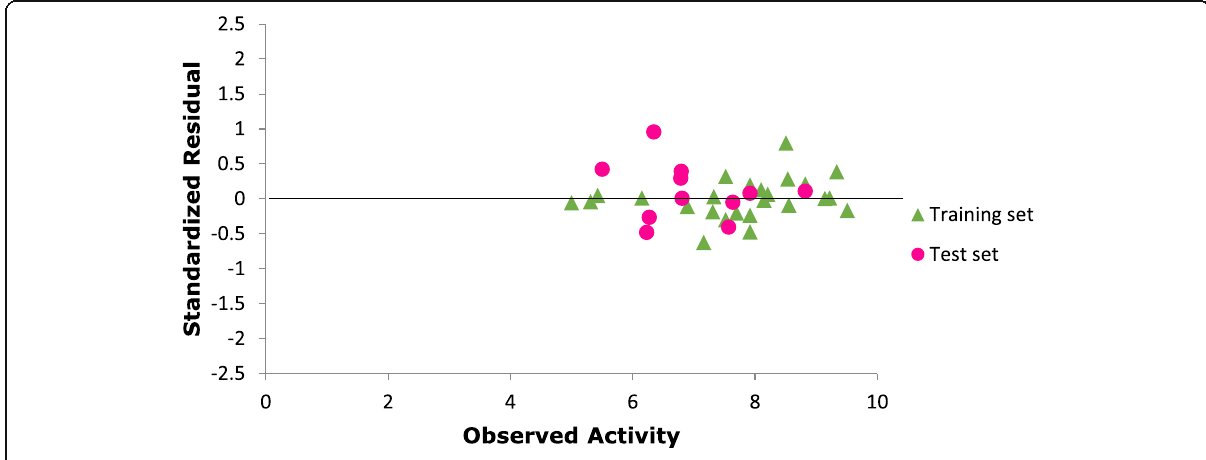
Fig. 3 Plot of standardized residual activity versus observed